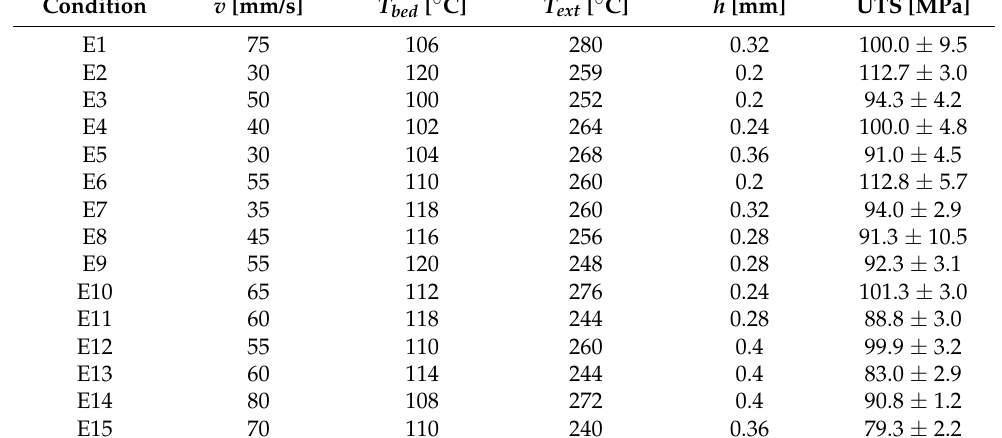
Table 4. Average UTS values for each condition used to validate the prediction model based on DOE.